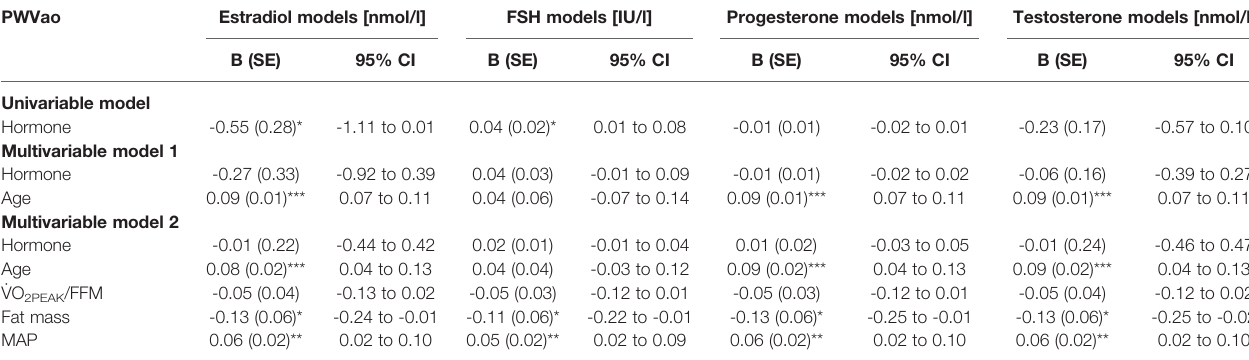
TABLE 3 | Associations of estradiol, follicle-stimulating hormone, progesterone, and testosterone with aortic pulse wave velocity. PWVao Estradiol models [nmol/l] FSH models [IU/l] Progesterone models [nmol/l] Testosterone models